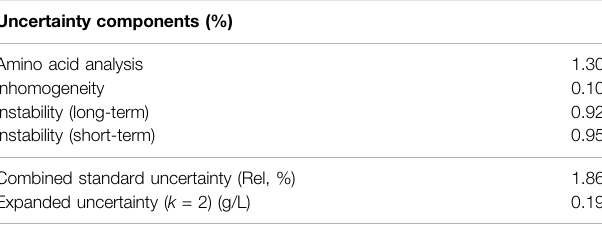
TABLE 4 | Uncertainty budget for the indicative value of NMIJ RM 6208a,